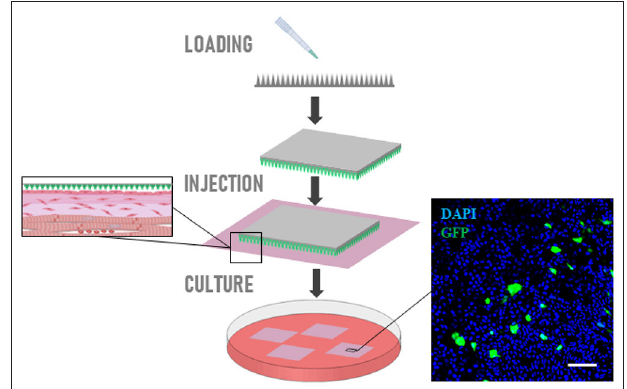
FIGURE 8 | Nanoinjection of plasmid. Schematic representation of nanoneedles-mediated delivery of GFP-carrying plasmid on epicardial cells. Confocal imaging indicated expression of GFP 48h after nanoinjection in the epicardium of cultured slices. Scale bars, 50 µ m.